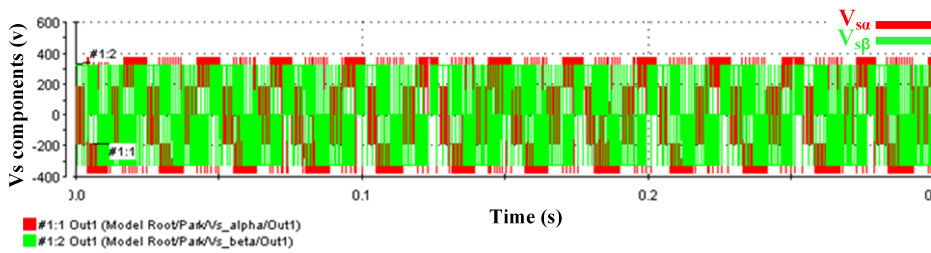
Figure 26. Experimental results of the stator voltage components of the improved strategy.